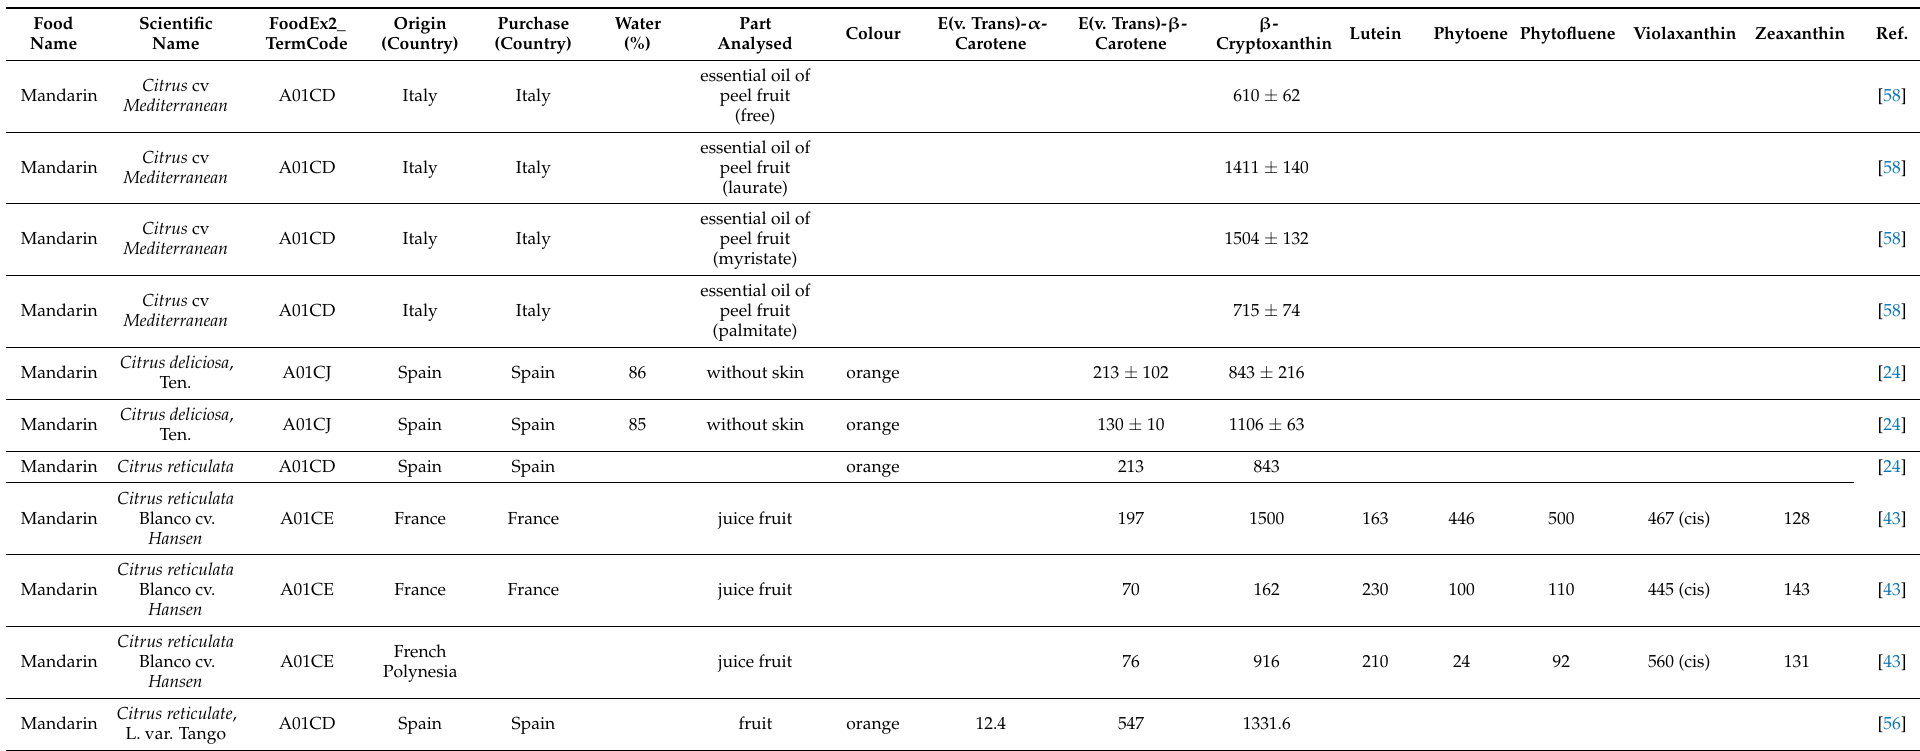
Table A3. Mandarins and similar (A01CB) ( µ g/100